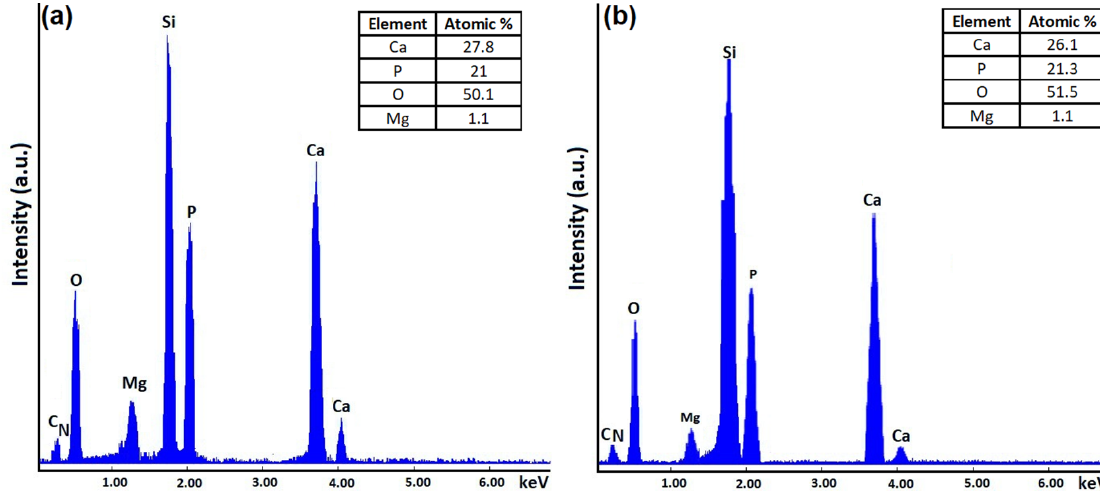
Figure 8. EDX spectra of 10 MgHApCh-3 ( a ) and 10 MgHApCh-6 ( b ) thin films.